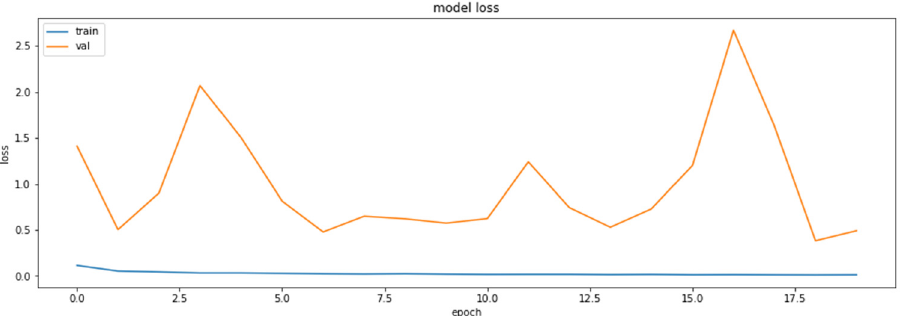
Figure 1. The loss function values for the training and the validation datasets obtained based on RestNet18 model.